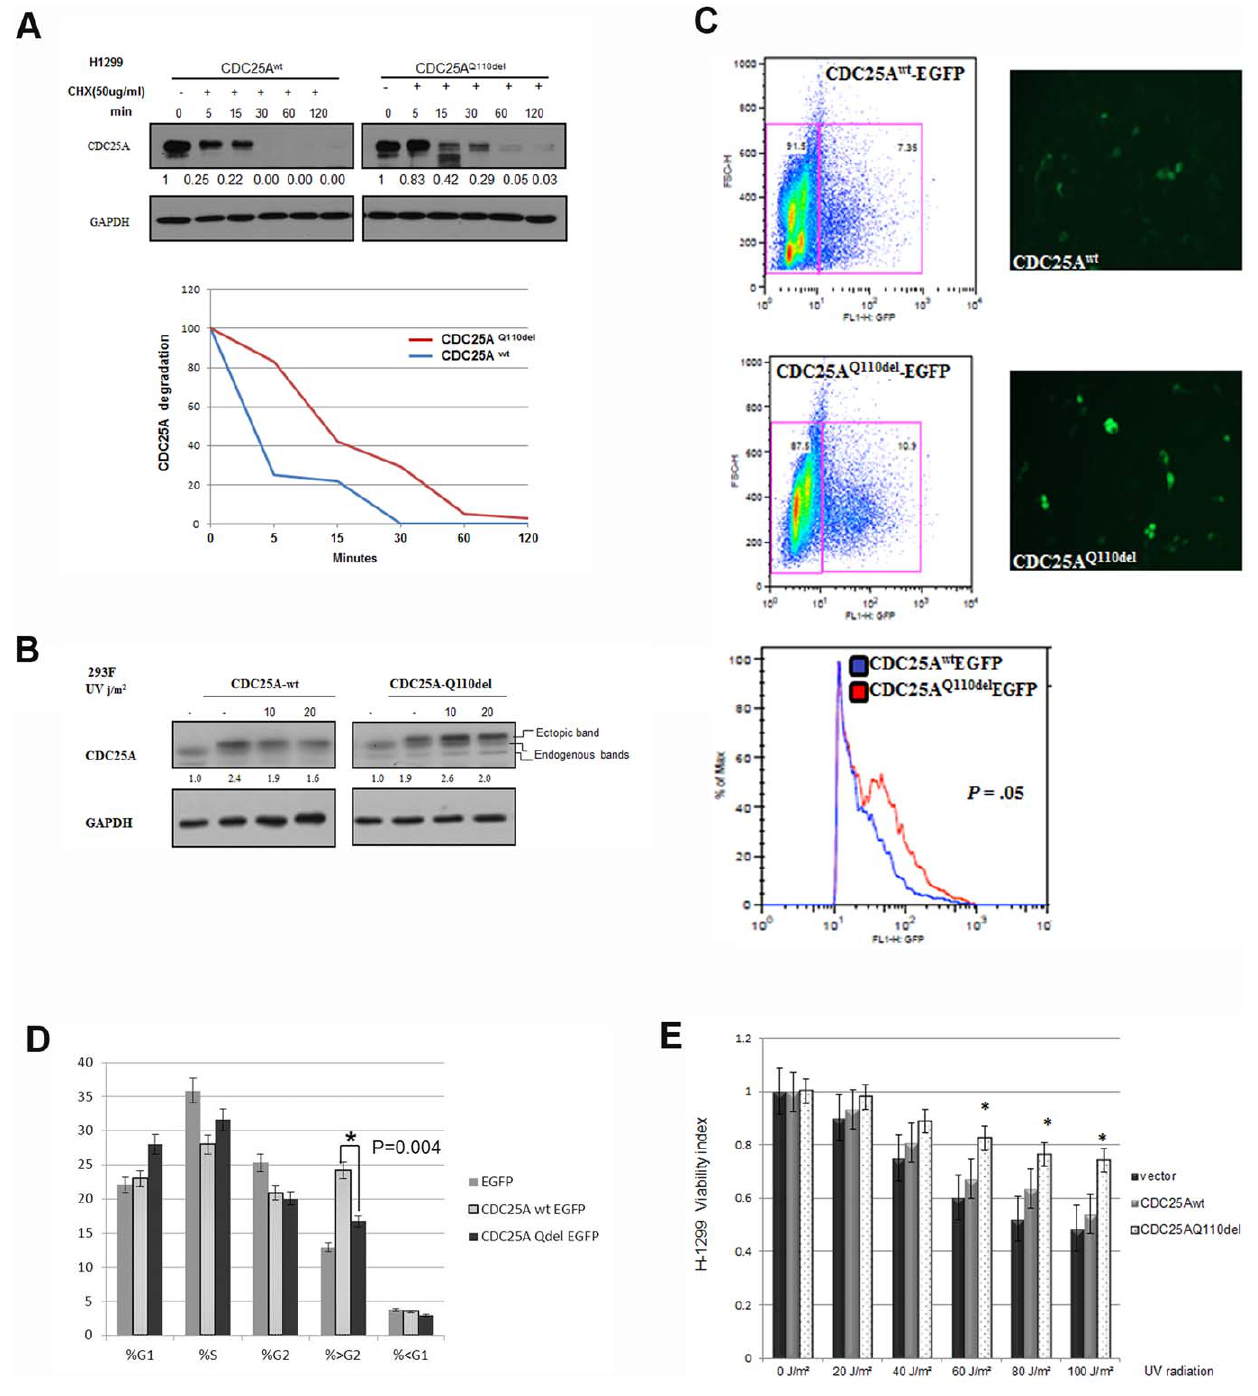
Figure 3. CDC25A Q110del confers more CDC25A protein stability and promotes cellular survival under UV radiation. A. Time course cyclohexamide (50 ug/ml) treatment of H1299 cells transfected with pEGFPN1-CDC25A wt or pEGFPN1-CDC25A Qdel under unperturbed conditions showed increased half-life of CDC25A Q110 ( , 15 minutes) versus CDC25A wt . B. UV radiation followed by 30 minutes incubation of 293F cells in 37 u C, CDC25A Q110del showed more stability compared to CDC25A wt . C. 293F cells plated at equal cell density and transfected with equal amount of EGFP labeled CDC25A Q110del or CDC25A wt . After 72 hrs of transfection, flowcytometry analysis gating equal number of EGFP expressing cells for each isoform. Histogram shows intensity of expression of CDC25A Q110del -EGFP (mean 59.2) versus CDC25A wt -EGFP (mean 40.5) (t-test P =.05). D. The same population of cells gated for EGFP-CDC25A expression was studied for cell cycle distribution. The CDC25A wt -EGFP showed to arrest in the post G2 phase ( . G2/M) compared to control (p=0.055). The EGFP-CDC25A Q110del expressing cells showed less accumulation of hyperploid cell population at the . G2/M phase and accelerated the cells more through mitosis compared to the EGFP-CDC25A wt expressing cells (p=0.0047). E. Cell viability assay of H1299 expressing CDC25A wt versus CDC25A Q110del after 24 hr of several doses of UV radiation. CDC25A Q110del expression rescued H1299 sensitivity to UV radiation in relation to the control group.